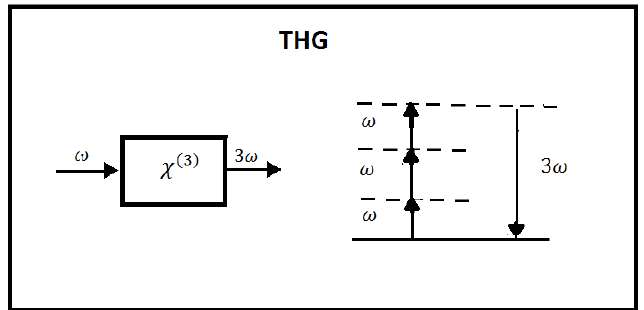
Figure 2. Third-harmonic generation. On the left is the geometry of the interaction, and on the right is the energy level diagram describing the interaction.